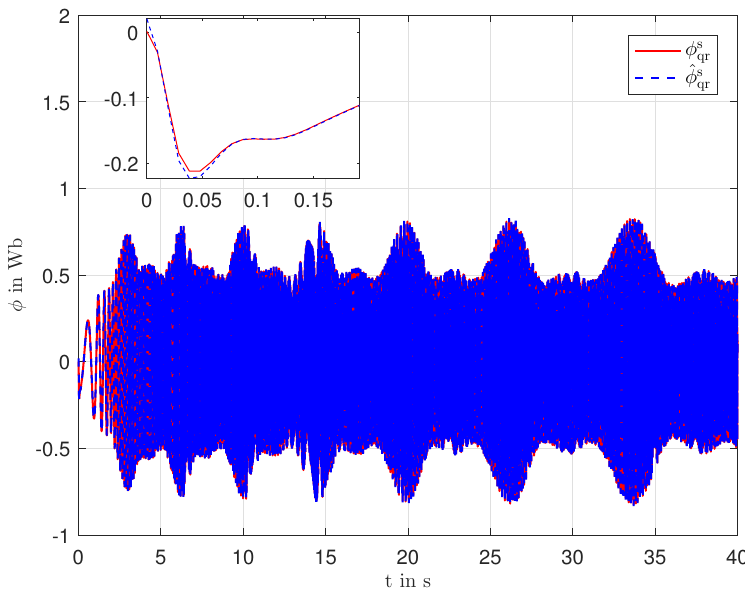
Figure 13. Actual and estimated q s axis flux of the IM.